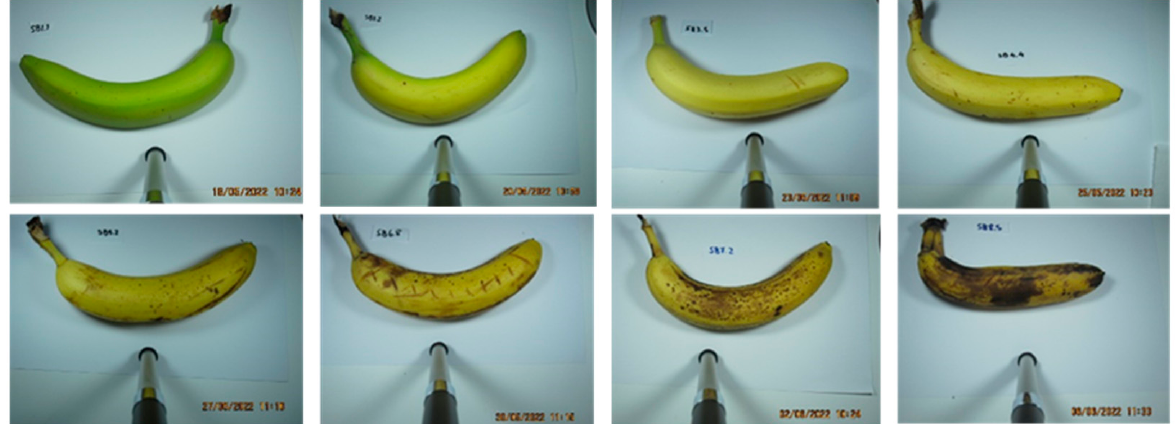
Figure 1. Representative images of the banana peel over a period of 21 days (i.e., days 2, 4, 7, 9, 11, 14, 17, 21) during fruit storage and ripening.